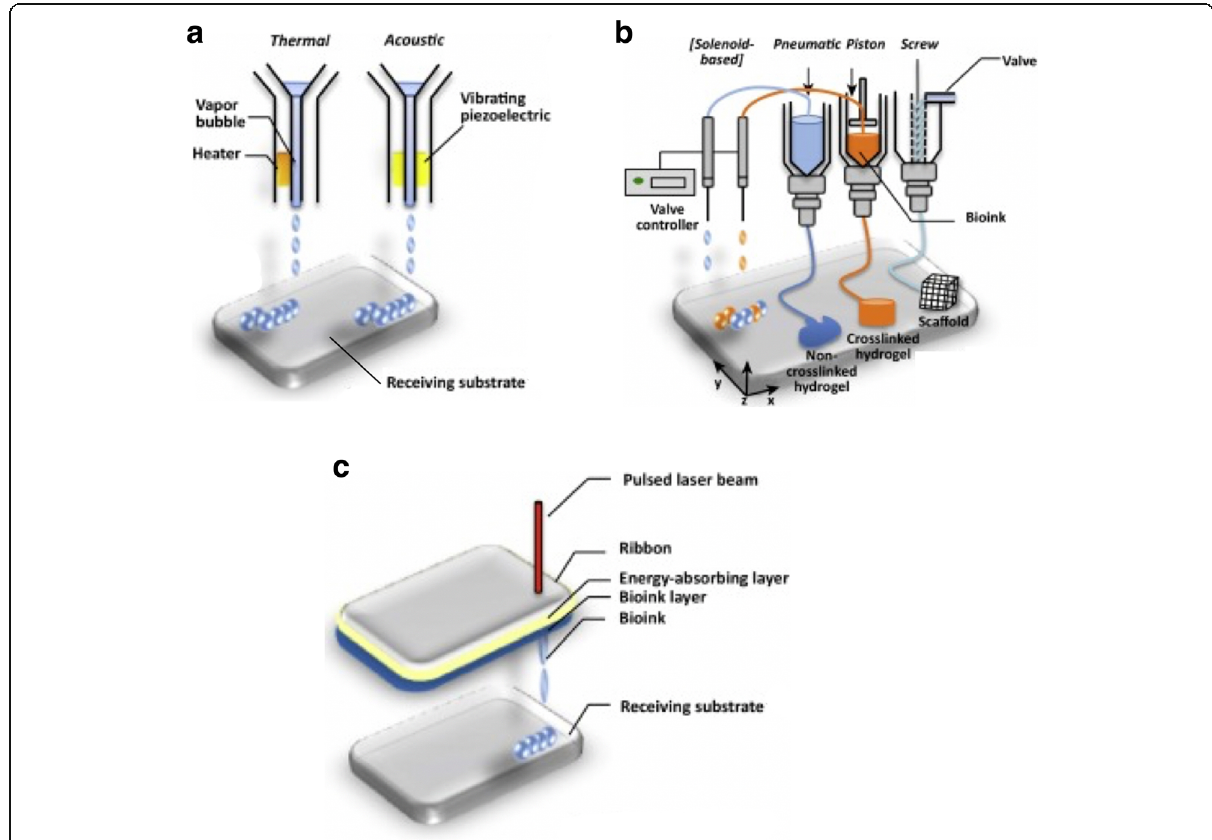
Fig. 1 Schematic representation of the 3D bioprinting techniques: a inkjet bioprinting, b micro-extrusion bioprinting, and c laser-assisted bioprinting (modified and adapted from Visscher et al.)